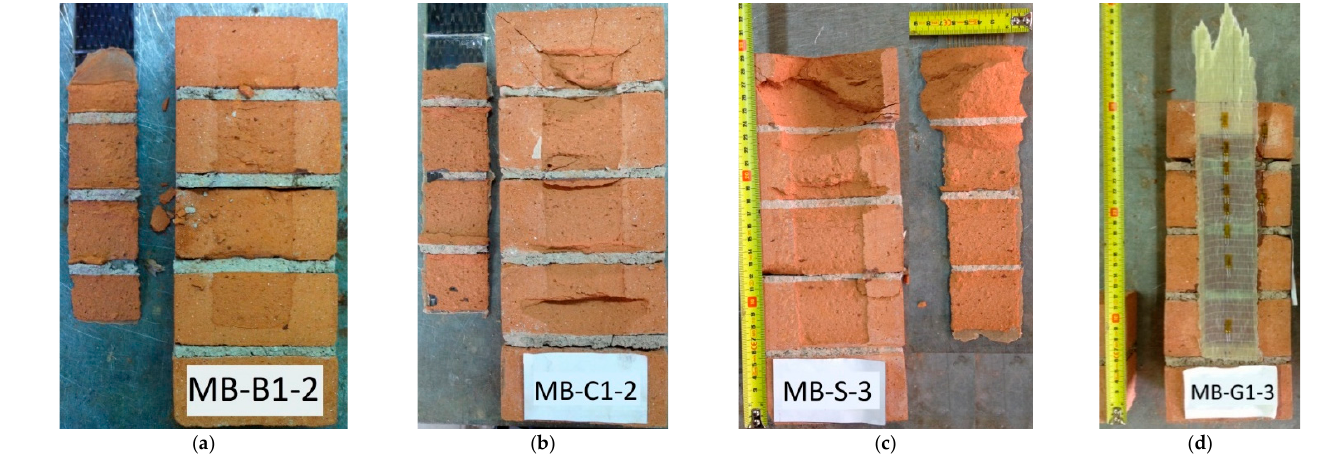
Figure 6. Failure mode for clay masonry unit: ( a ) MB-B1-2; ( b ) MB-C1-2; ( c ) MB-S-3; ( d ) MB-G1-3.